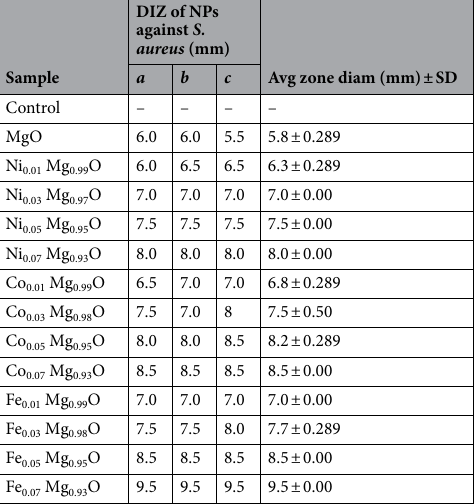
DIZ of NPs against S. aureus